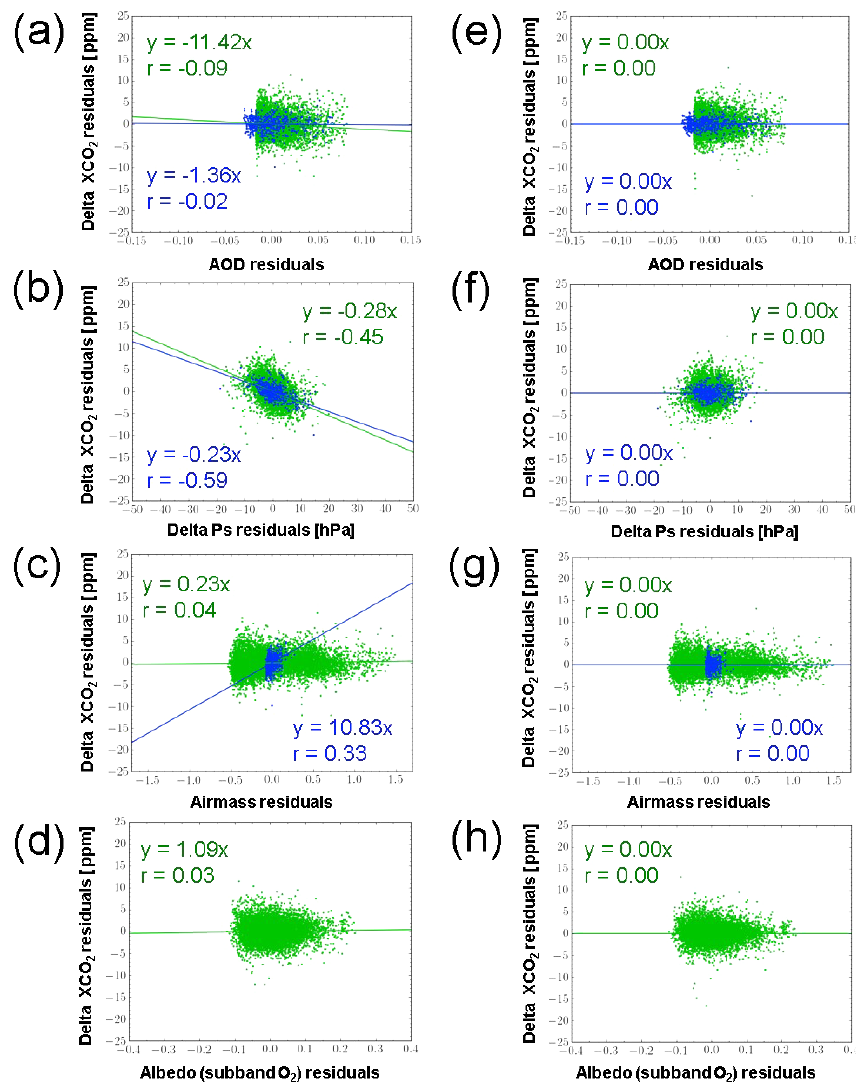
Figure 2. Scatter diagrams between (cid:49) XCO 2 calculated from uncorrected GOSAT data and (a) the retrieved aerosol optical depth, (b) the difference between the retrieved and a priori surface pressures, (c) airmass, and (d) surface albedo for the O 2 A-band. Scatter diagrams between (cid:49) XCO 2 calculated from corrected GOSAT data and (e) the retrieved aerosol optical depth, (f) the difference between the retrieved and a priori surface pressures, (g) airmass, and (h) surface albedo for the O 2 A-band. Green (blue) dots and lines indicate the GOSAT data and regression lines over land (ocean)